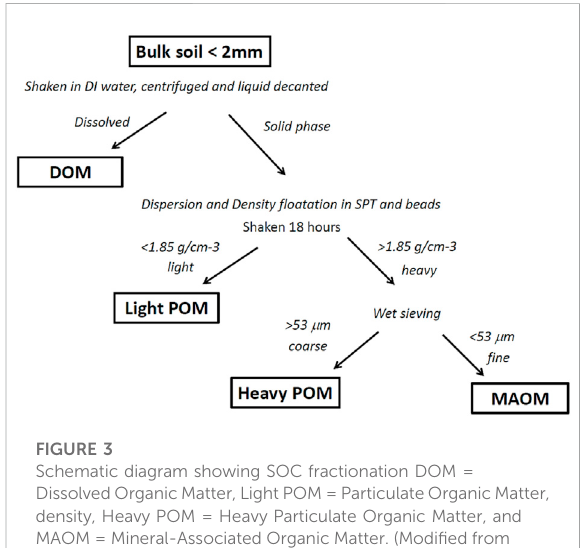
FIGURE 3 Schematic diagram showing SOC fractionation DOM = DissolvedOrganicMatter,LightPOM=ParticulateOrganicMatter, density, Heavy POM = Heavy Particulate Organic Matter, and MAOM = Mineral-Associated Organic Matter. (Modi fi ed from Robertson et al., 2019).